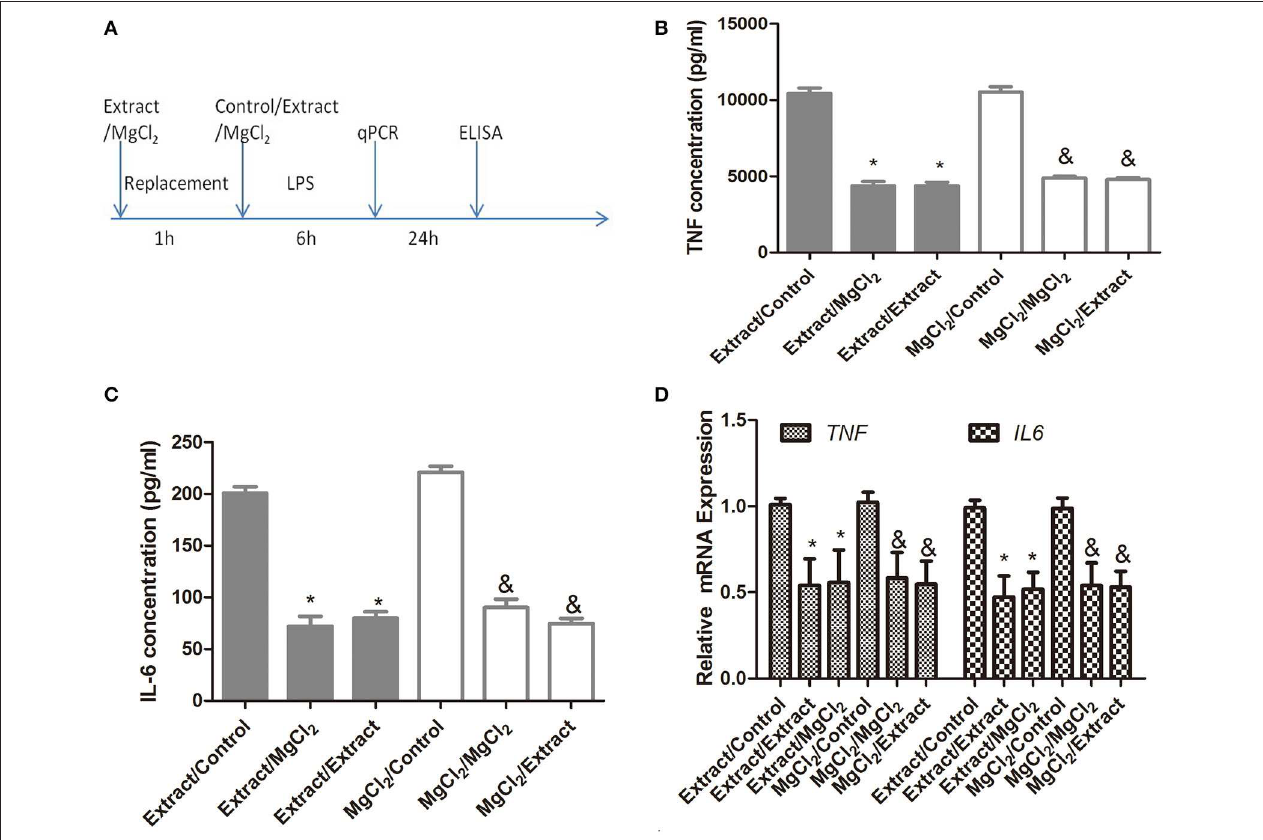
FIGURE 3 | The reversible anti-inflammatory effects of extract and MgCl 2 (A) THP-1 cell-derived macrophages were cultured with extract or MgCl 2 for 1h and replaced with extract, MgCl 2 , or normal media (control) in the presence of LPS for the indicated times. The protein expression of TNF (B) and IL-6 (C) in supernatants was determined at 24h by ELISA. The mRNA expression of TNF (C) and IL-6 (D) was analyzed with qPCR at 6h. & P < 0.05 vs. MgCl 2 /control group; * P < 0.05 vs. extract/control group. LPS, lipopolysaccharide; TNF, tumor necrosis factor; IL,